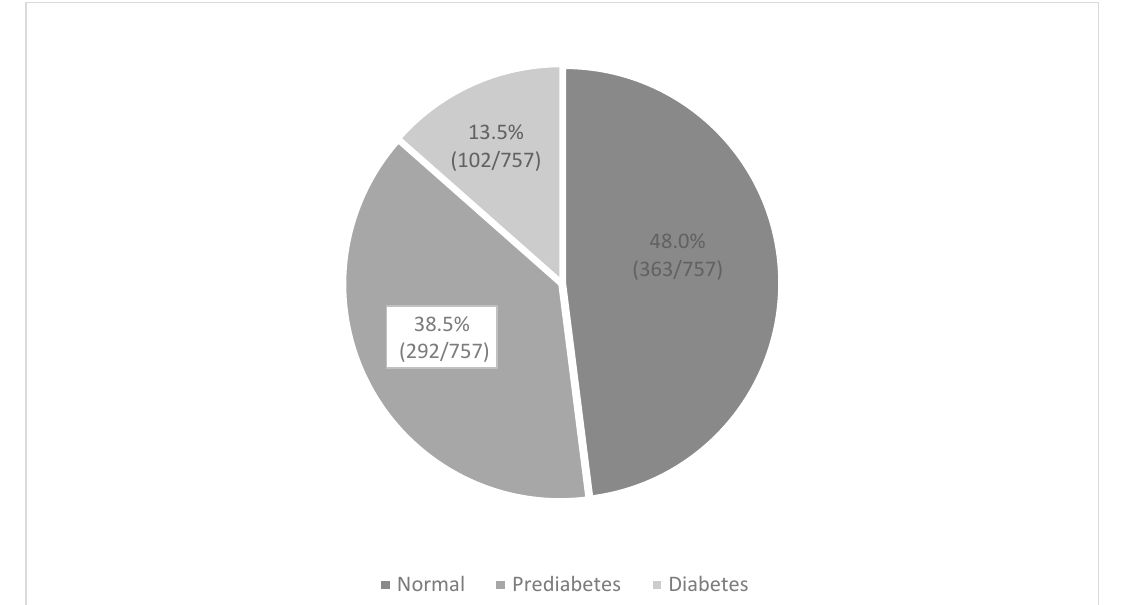
Figure 1. Prevalence of prediabetes and diabetes in the study population.